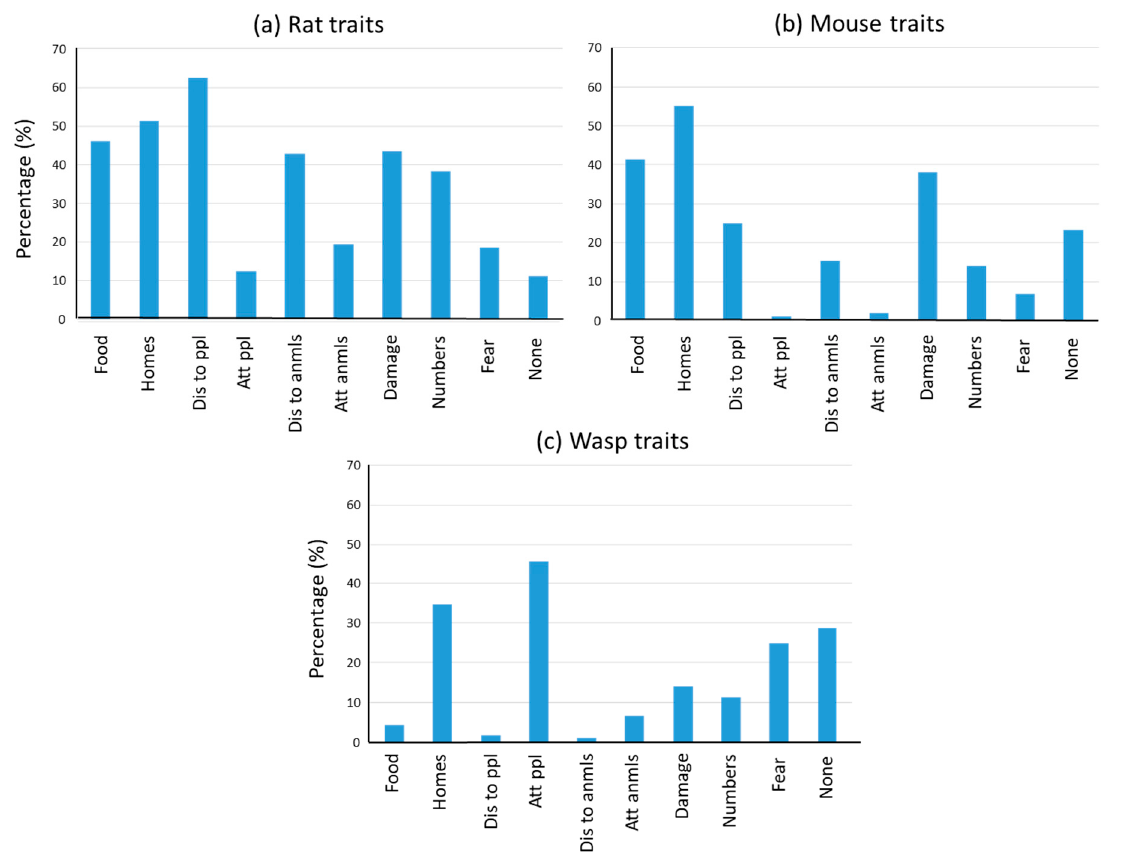
Figure 3. Traits attributed to: ( a ) rats; ( b ) mice; and ( c ) wasps (percentage of people attributing, n = 2000 per species). The traits are in order: ‘Eat our food’, ‘Enter homes’, ‘Spread disease to people’, ‘Attack people’, ‘Spread disease to pets/domestic poultry’, ‘Attack pets/domestic poultry’, ‘Damage property’, ‘Numbers are out of control’, ‘I’m afraid of them’, ‘None’.